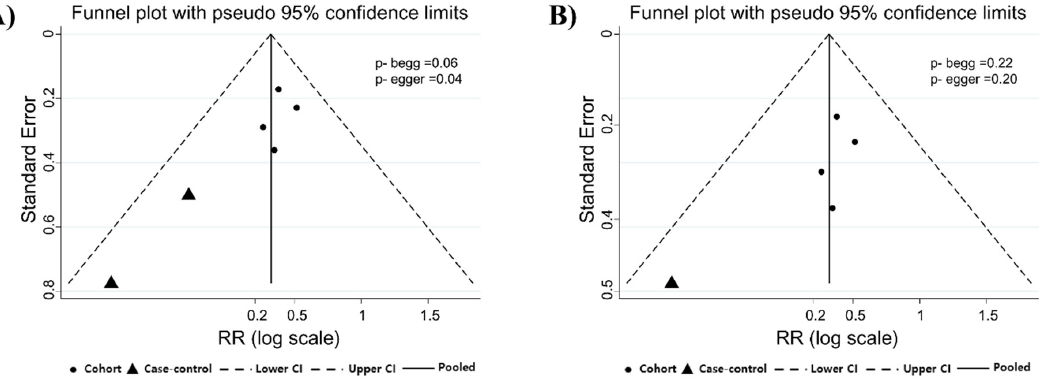
Figure 3. Funnel plot for publication bias in meta-analysis on the association between the risk of spontaneous abortion and photo-lithography work: before sensitivity analysis ( A ); and after sensitivity analysis ( B ).